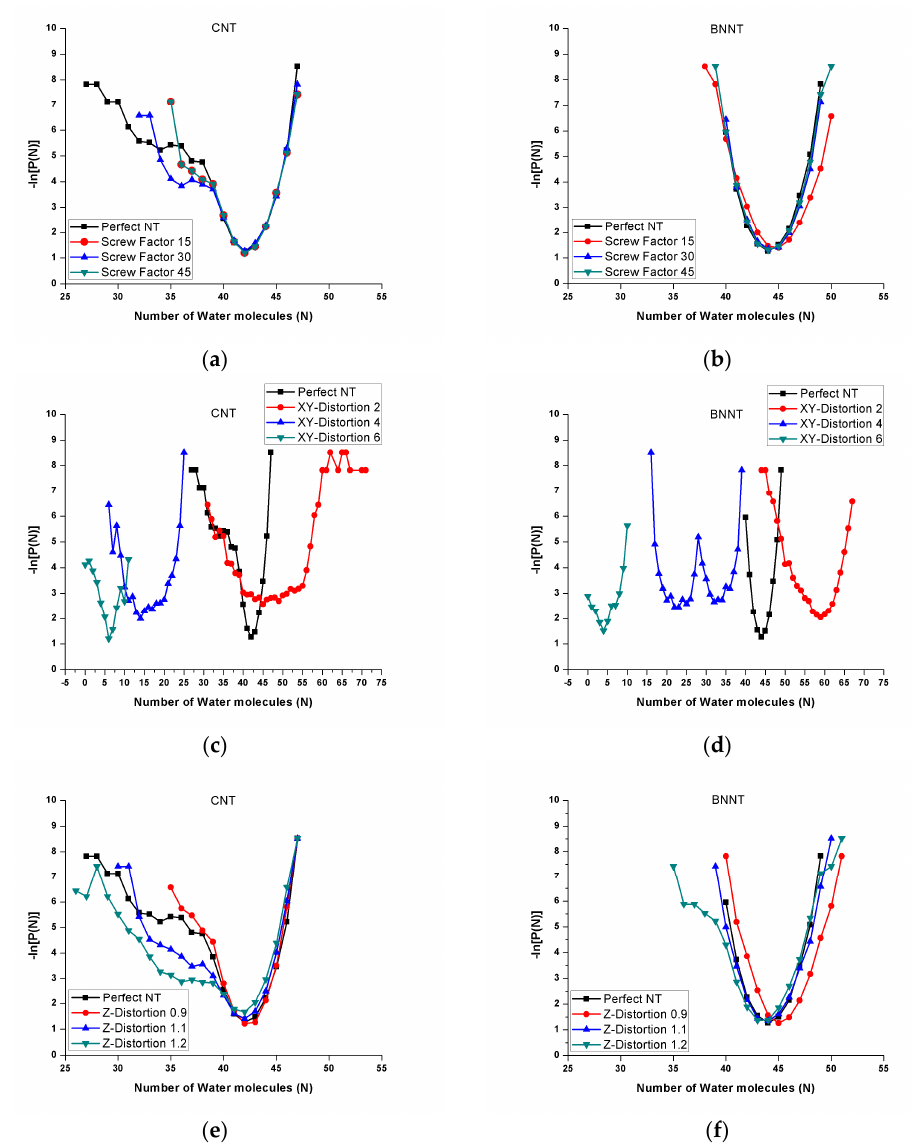
Figure 4. Free energy of occupancy fluctuation as a function of number of water molecules inside and different types of deformed nanotubes compared with perfect nanotubes: ( a ) carbon nanotube (CNT) with screw distortions; ( b ) boron nitride nanotube (BNNT) with screw distortions; ( c ) carbon nanotube (CNT) with XY-distortion; ( d ) boron nitride nanotube (BNNT) with XY-distortion; ( e ) carbon nanotube (CNT) with Z-distortion nanotube; and ( f ) boron nitride nanotube (BNNT) with Z-distortion.